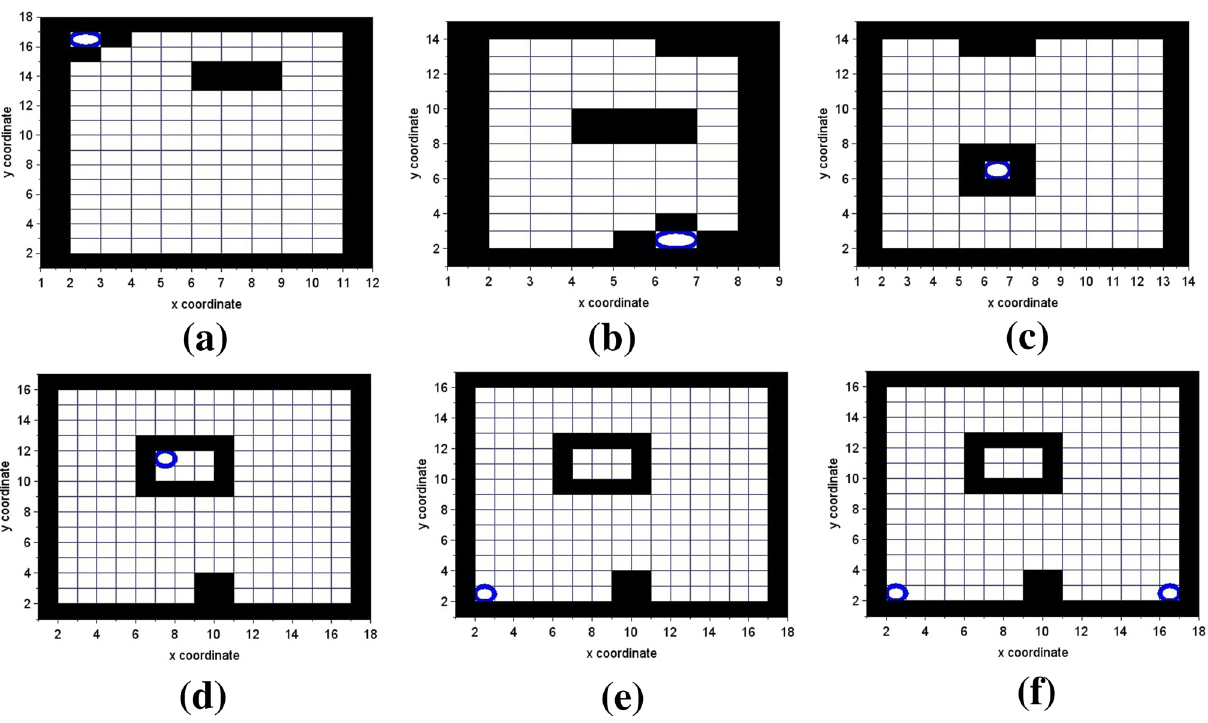
Fig. 4 Different environmental conditions which lead to incomplete grid coverage by mobile robots